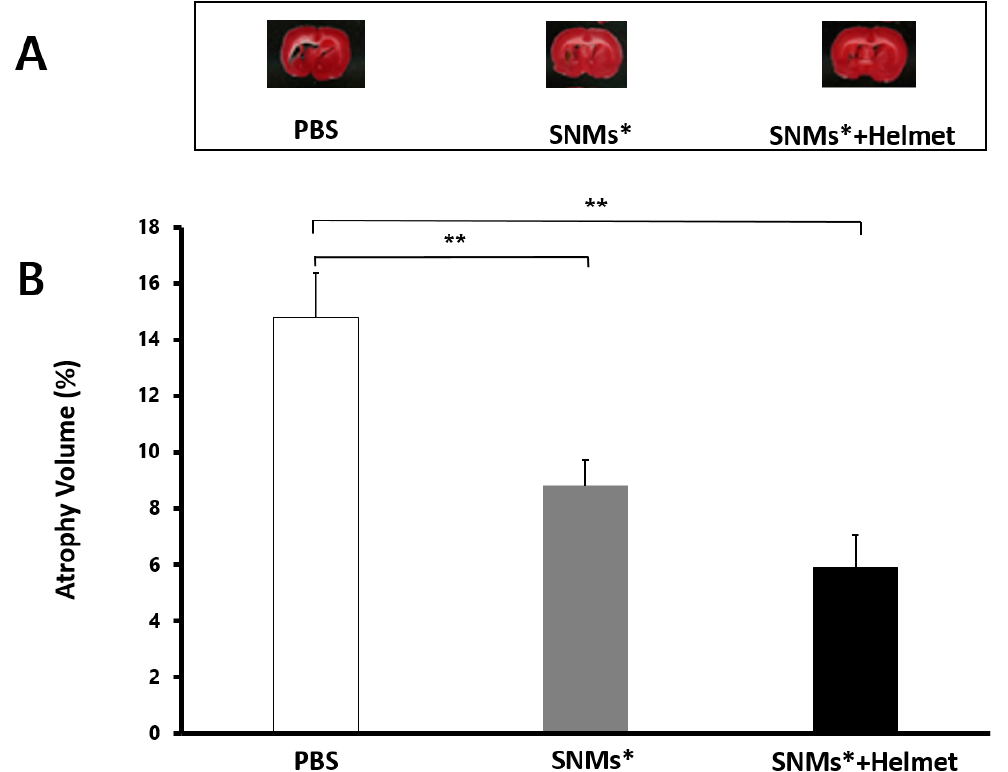
Figure 9. Atrophy volume after ICH induction. Atrophy size of rat brains was measured by triphenyl tetrazolium chloride-stained sections 42 days after induction of ICH. ( A ) Representative microphotographs are shown. ( B ) The atrophy volume in the ICH model, analyzed using an image analyzer, showed a significant decrease in the SNMs* and SNMs*+Helmet groups compared with that in the PBS group. (** p < 0.005; n = 6 for each group in each test).